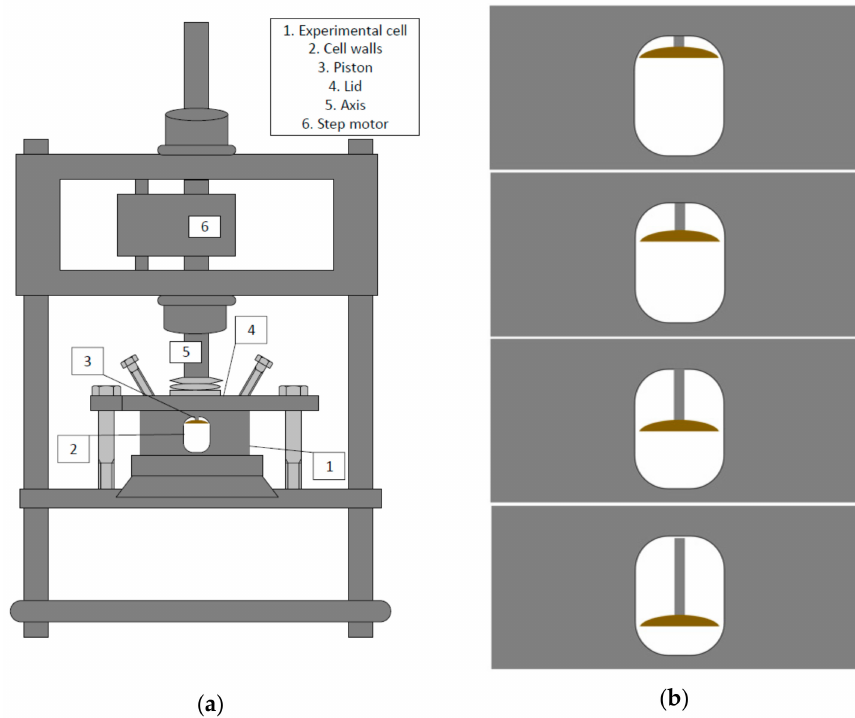
Figure 1. Schematic representation of the ( a ) pulsating emulsification device and ( b ) subsequent positions of the piston as it moves downwards during a pulsation.